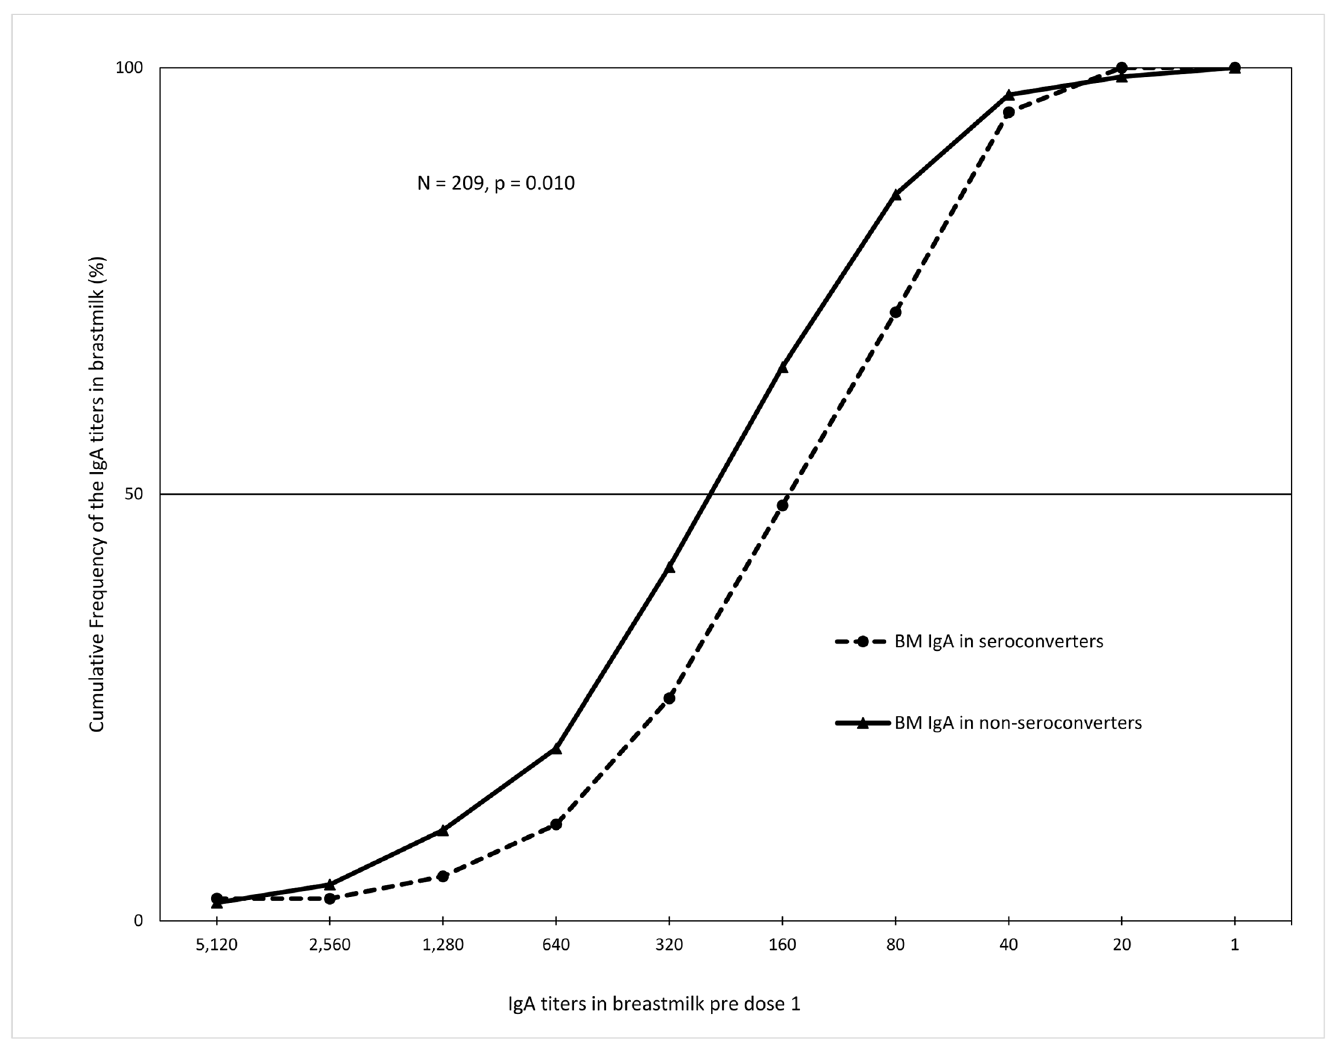
Fig 2. Cumulative frequency profiles of RV-IgA titres in pre dose 1 breastmilk of 216 mother-infant pairs by infant IgA seroconversion post dose 2 of rotavirus vaccine. Seroconversion was defined as four-fold increase in rotavirus-specific IgA titres in post dose 2 sera when compared to the corresponding pre-immunization